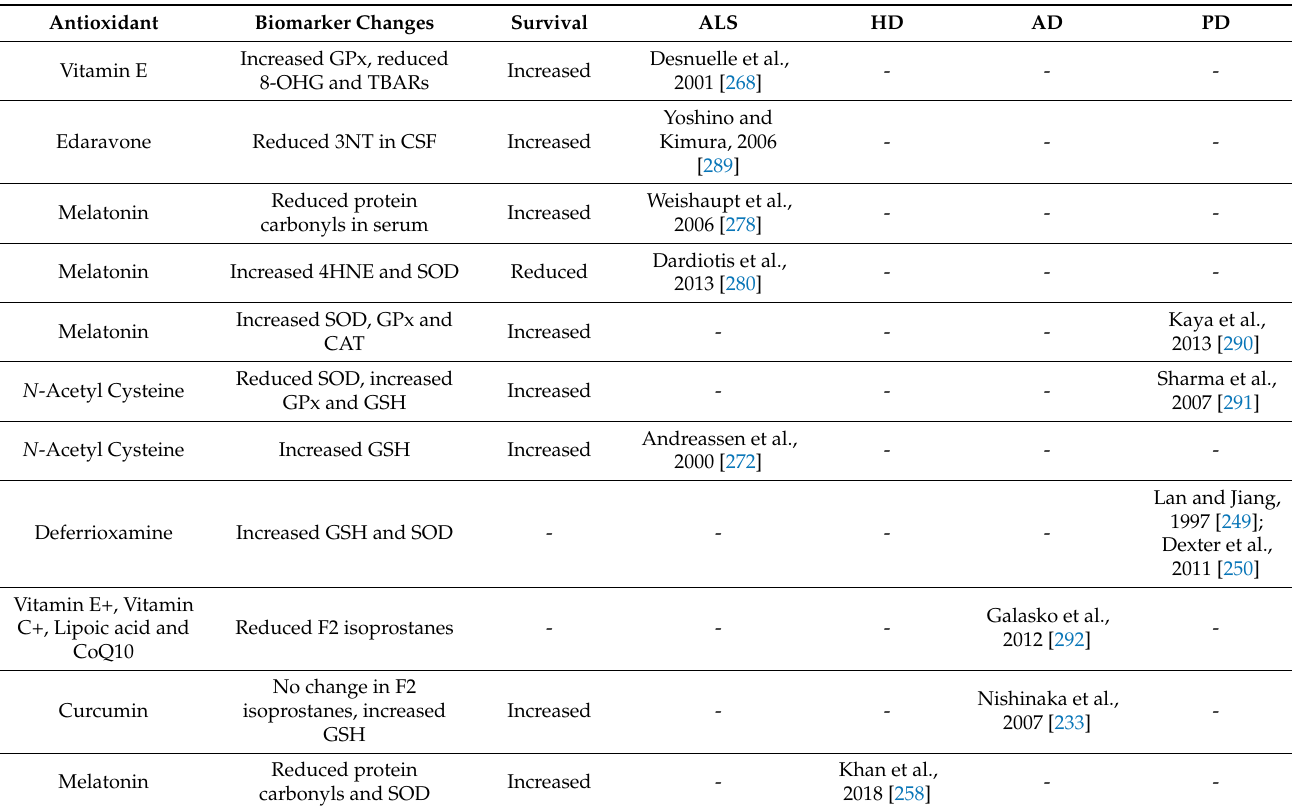
Table 4. Effects of antioxidant therapies in neurodegenerative